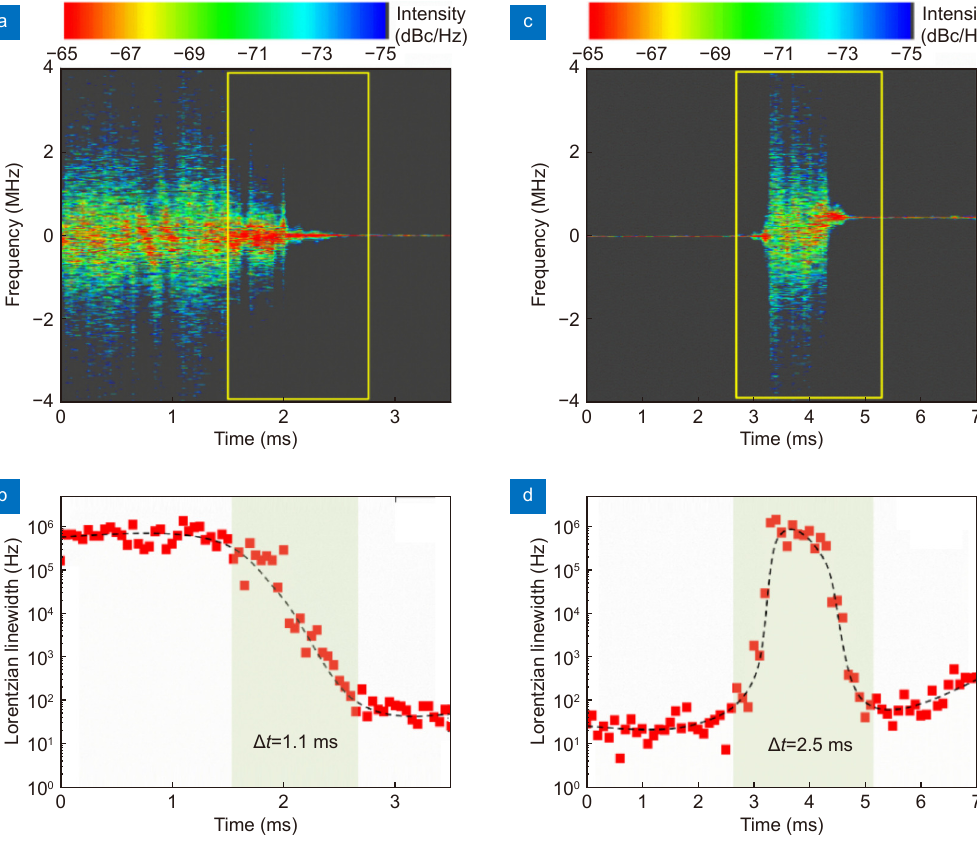
Fig. 6 | Self-adaptive compression process of laser linewidth. ( a ) Transient spectrum and ( b ) corresponding Lorentzian linewidth when switching on the feedback. ( c ) Transient spectrum and ( d ) corresponding Lorentzian linewidth when tuning the frequency of the main laser